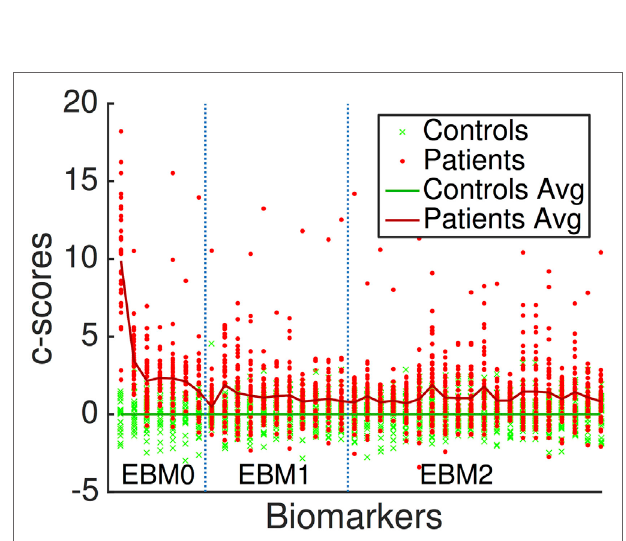
FigUre 3 | Standardized “c-scores” for all biomarkers included in our analyses. Non-network markers are to the left, denoted EBM0. Network metrics are to the right, delineated by EBM1 (hubs, i.e., basic measures of centrality) and EBM2 (importance, i.e., advanced measures of centrality and shortest paths). EBM3 was not generated since no segregation/integration- based network measures contained disease signal. EBM4 includes all biomarkers.